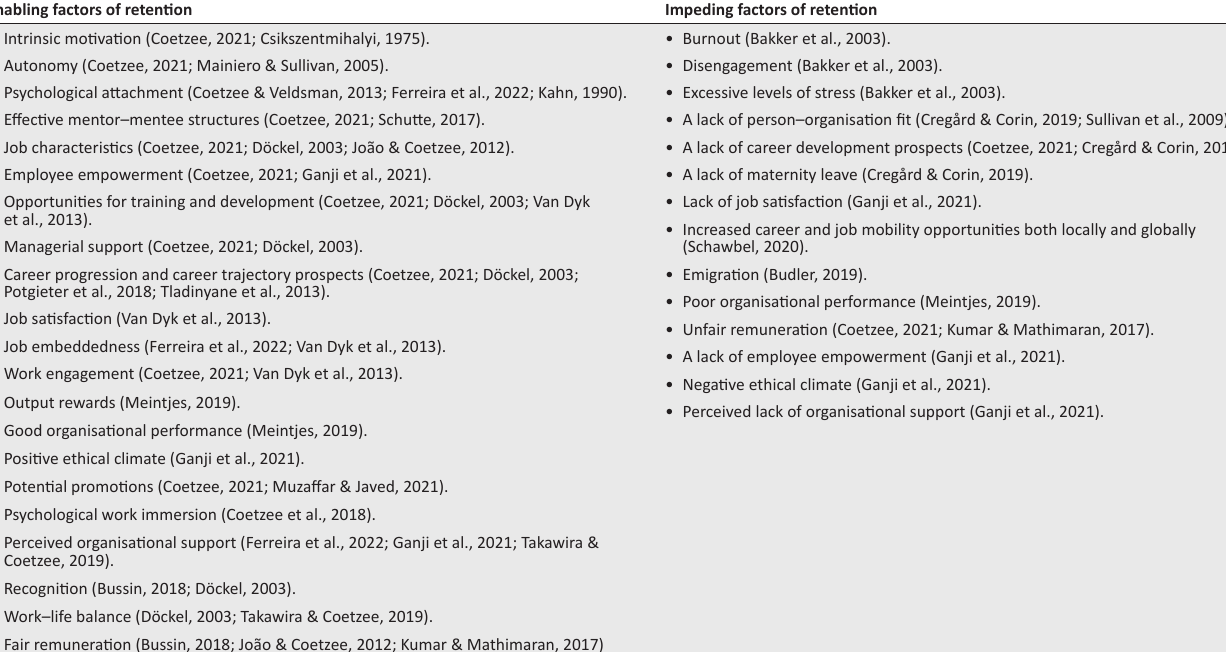
TABLE 1: Core research trends on enabling and impeding factors of